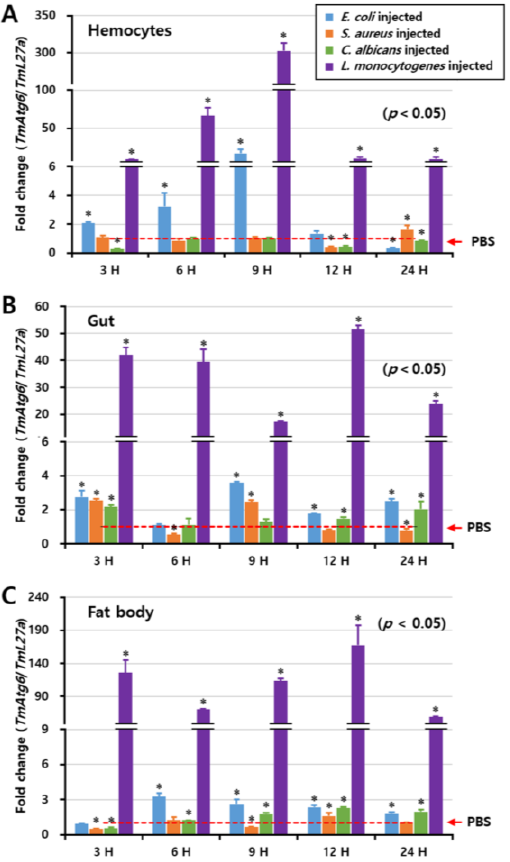
Figure 4. Induction patterns of TmAtg6 in different tissues against E. coli, S. aureus, C. albicans, and L. monocytogenes, including hemocytes ( A ), gut ( B ), and fat body ( C ). The induction pattern analysis of TmAtg6 gene in different tissues of T. molitor young larvae was performed by injection of E. coli (10 6 cells/μ L), S. aureus (10 6 cells/μ L), C. albicans (5 × 10 4 cells/μ L), or L. monocytogenes (10 6 cells/μ L). Samples were collected at different time points such as 3, 6, 9, 12, and 24 h post-injection of microorganisms. Twenty young larvae of mealworm were used at each time point. In hemocytes, TmAtg6 gene was highly induced at 9 h post-injection of L. monocytogenes . In the gut, the injection of L. monocytogenes highly induced the expression of TmAtg6 at 3 h post-injection, gradually decreased during 6 and 9 h, and then highly induced levels of TmAtg6 12 h post-injection. In the fat body, injection of L. monocytogenes highly induced TmAtg6 at 12 h post-infection.